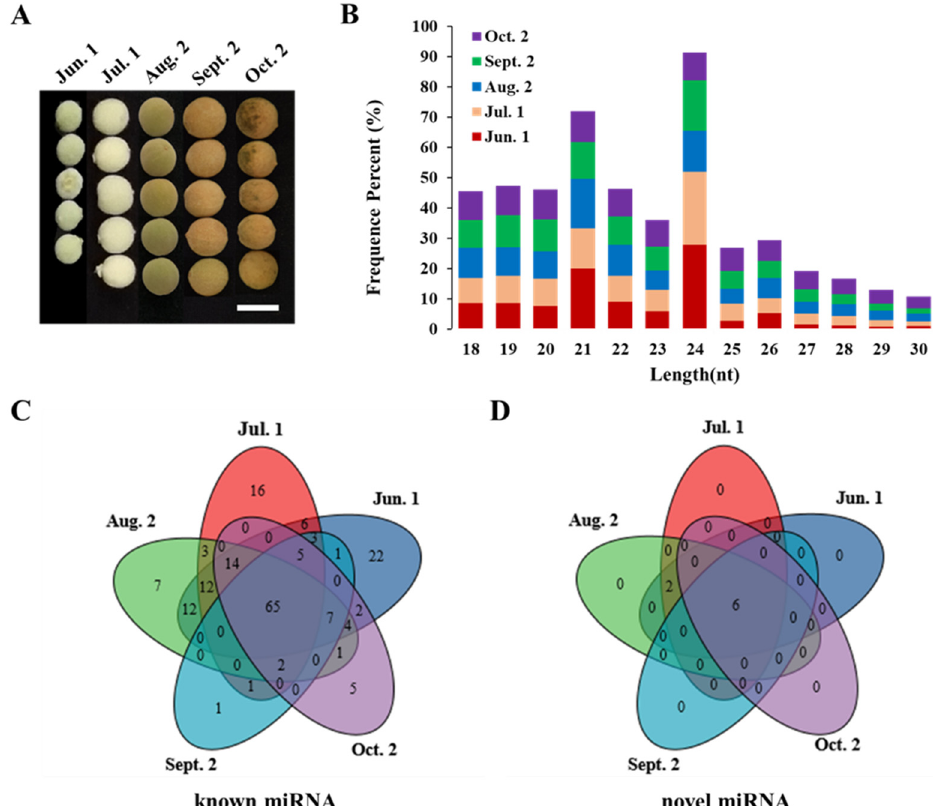
Figure 1. Overview of small RNAs expressed during seed maturation in T. tuan . ( A ) Stages of seed maturation used for small RNA sequencing. The images were taken during the sampling period on June 1, July 1, August 2, September 2, and October 2, 2019 (5 time points). Scale bars of 1 cm. ( B ) Size distribution of small RNA at five different seed maturation time stages in T. tuan . Jun. 1, Jul. 1, Aug. 2, Sept. 2 and Oct. 2 represent T. tuan seed collected at June time point, July time point, August time point, September time point, and October time point 2019, respectively. The abscissa is the length of miRNAs, and the ordinate is the percentage of miRNA at that length. ( C , D ) Venn diagram showing known miRNAs and novel miRNAs among five samples.